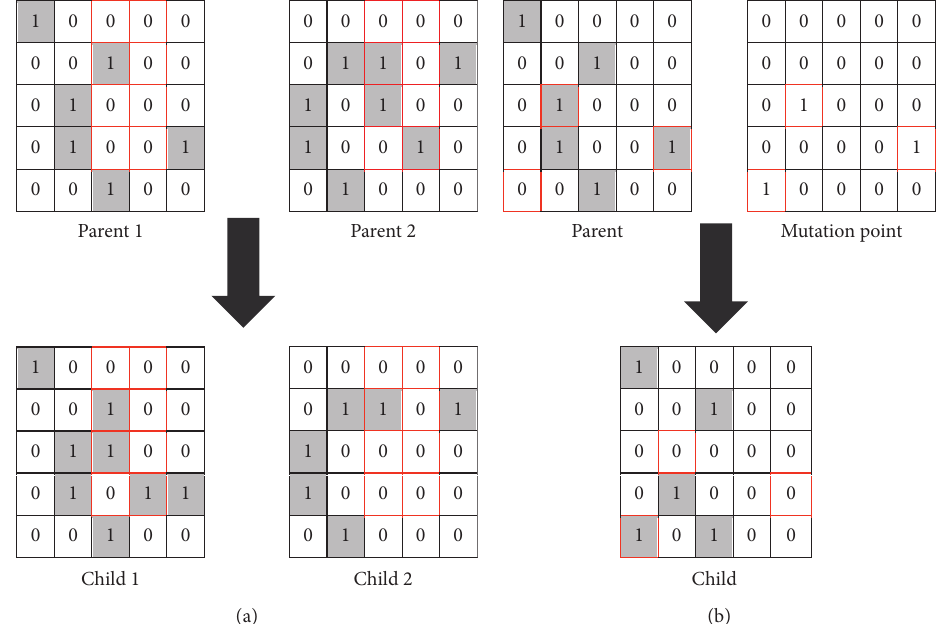
Figure 5: Illustration of operators. (a) Crossover operators (crossover points are (1, 3) and (4, 4)). (b) Mutation